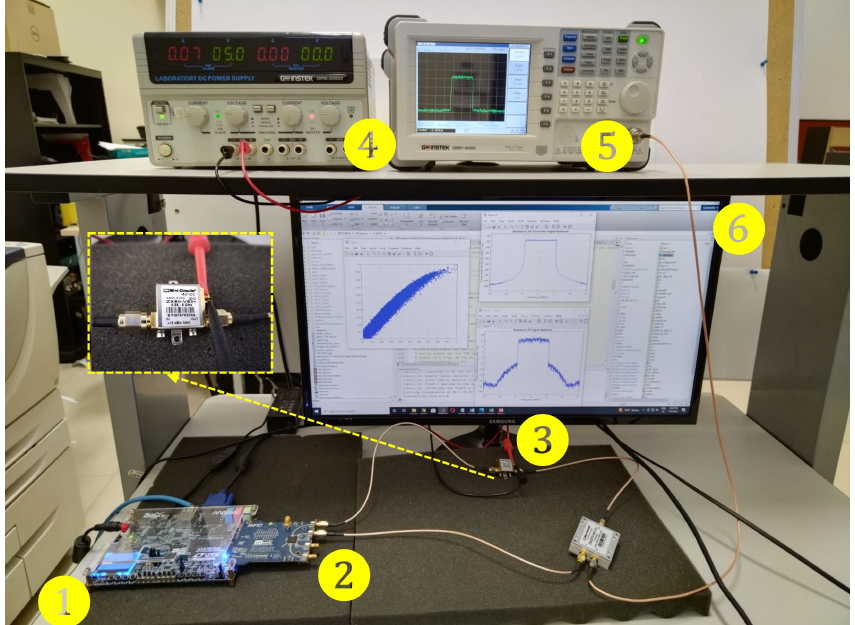
Figure 9. Experimental testbed photograph. Relevant instruments depicted as follows. 1: Altera Cyclone V FPGA SoC-Kit. 2: AD9361 RF Agile Transceiver working at 2.45 GHz center frequency. 3: Power amplifier Mini-Circuits ZX60-V63 + . 4: Power Supply GW INSTEK GPS-3303. 5: Spectrum Analyzer GW INSTEK GSP-830. 6: Display HOST